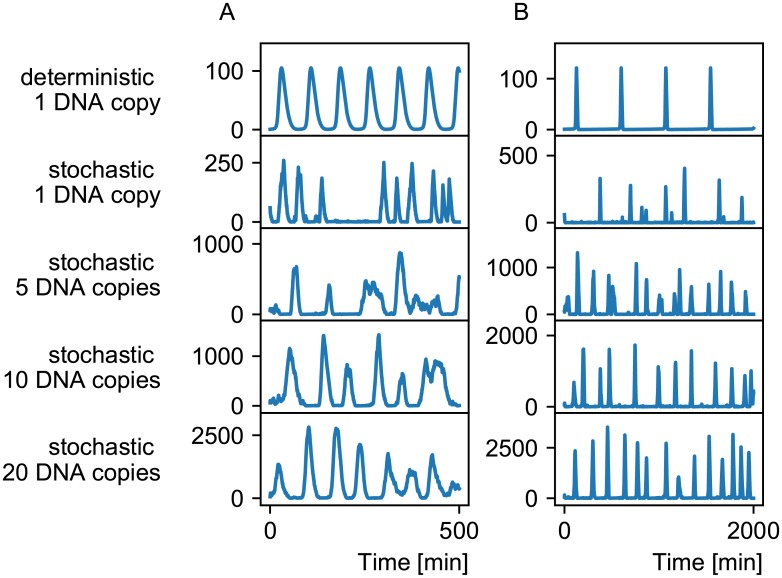
Stochastic time series.Time series of two examples of Ss-LrpB compatible systems are shown (A and B), in a deterministic and stochastic models from 1 to 20 DNA copy numbers. The oscillations become more regular for higher copy numbers. Note that the frequency is higher in the stochastic models with respect to the deterministic model for the example on the right.